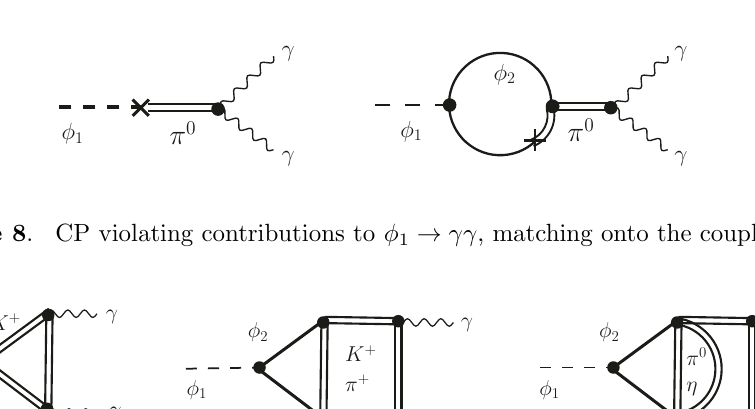
Figure 9 . CP conserving contributions to (cid:30) 1